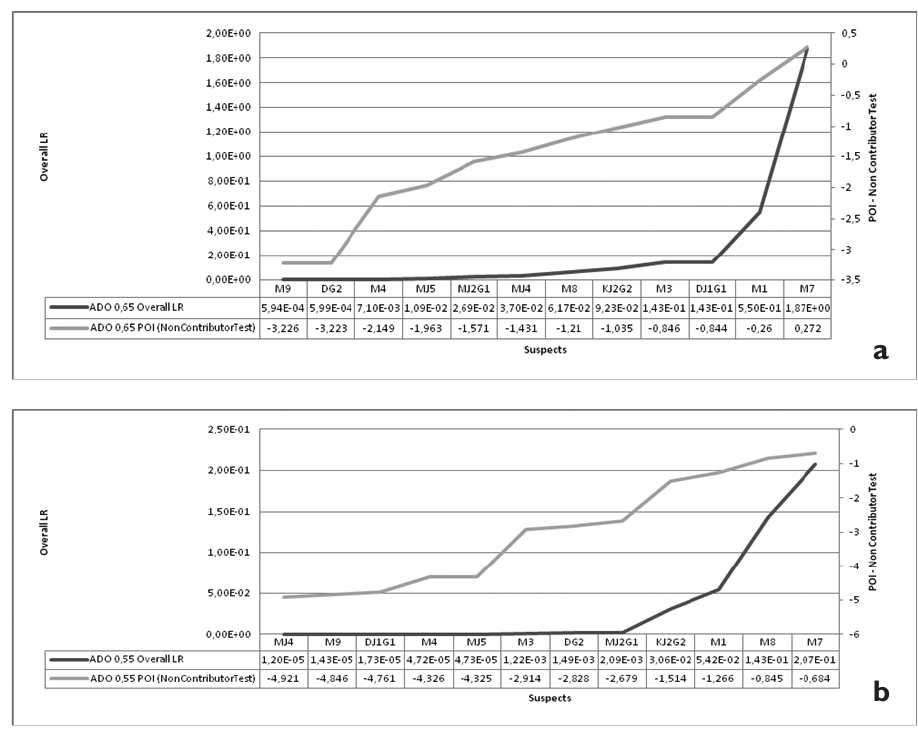
Figure 3. Non-contributor test results in comparison to the Overall LR value for each tested subject. a Global Consensus with ADO 0.65 b Global Composite with ADO